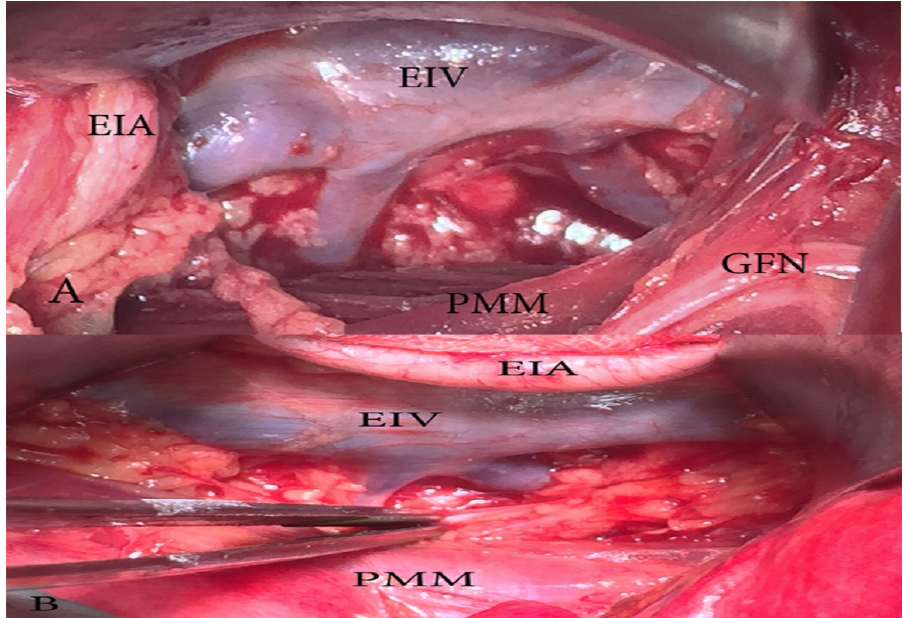
Figure 15. ILV or ALV drain into the EIV (open surgery right pelvic sidewall). We can only speculate if these veins are ILV, ALV, or both. ( A ) Two separate veins drain into the EIV. The EIA is retracted medially. ( B ) Two veins drain into the EIV via common trunk.